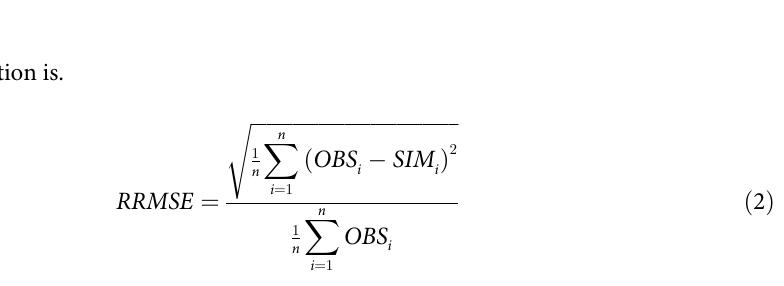
Fig 13. Tubers of different shapes. (a) Long potato; (b) Spherical potato; and (c) Ellipsoid potato.